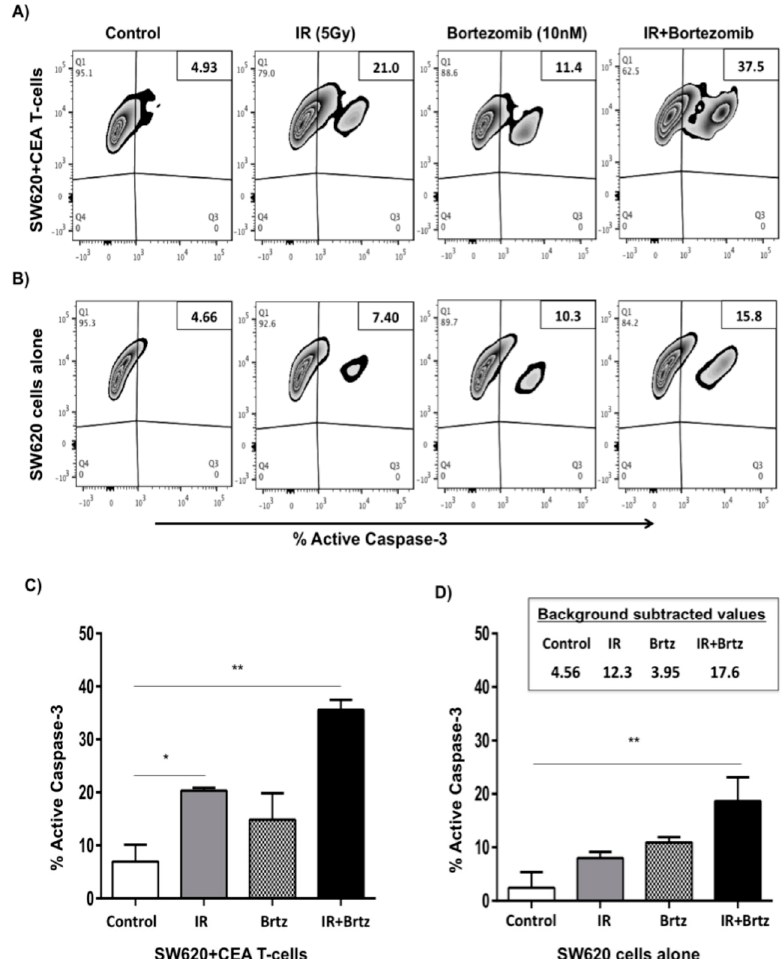
Figure 5. Combination of sub-lethal irradiation and bortezomib or irradiation alone enhances the killing of CRC mediated by CTLs. ( A ) SW620 cells were treated with 5 Gy, bortezomib or combination of radiation and bortezomib. Cells were harvested and co-incubated with human CEA specific CTLs (E:T ratio 10:1) for 3.5 h at 37 °C in a 96 well plate. The frequency of tumor cells expressing active caspase-3 was determined by flow cytometry and data was analyzed by flowjo software; ( B ) As a negative control, SW620 cells were treated and incubated under similar condition as described above in the absence of CTLs; ( C , D ) Bar graph showing the average of two additional replicate experiments. Error bars represent the SEM. * indicates p value <0.05. ** indicate p value <0.005. CEA = Carcinoembryonic antigen and E:T, effector cell to target cell ratio.